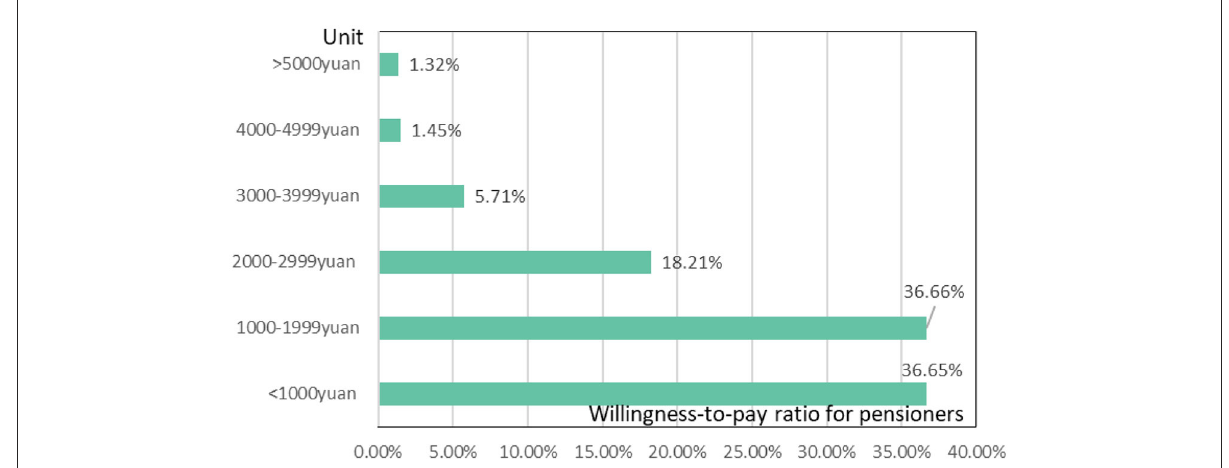
FIGURE11 Elderly people’s willingness to pay for a place in a residential care